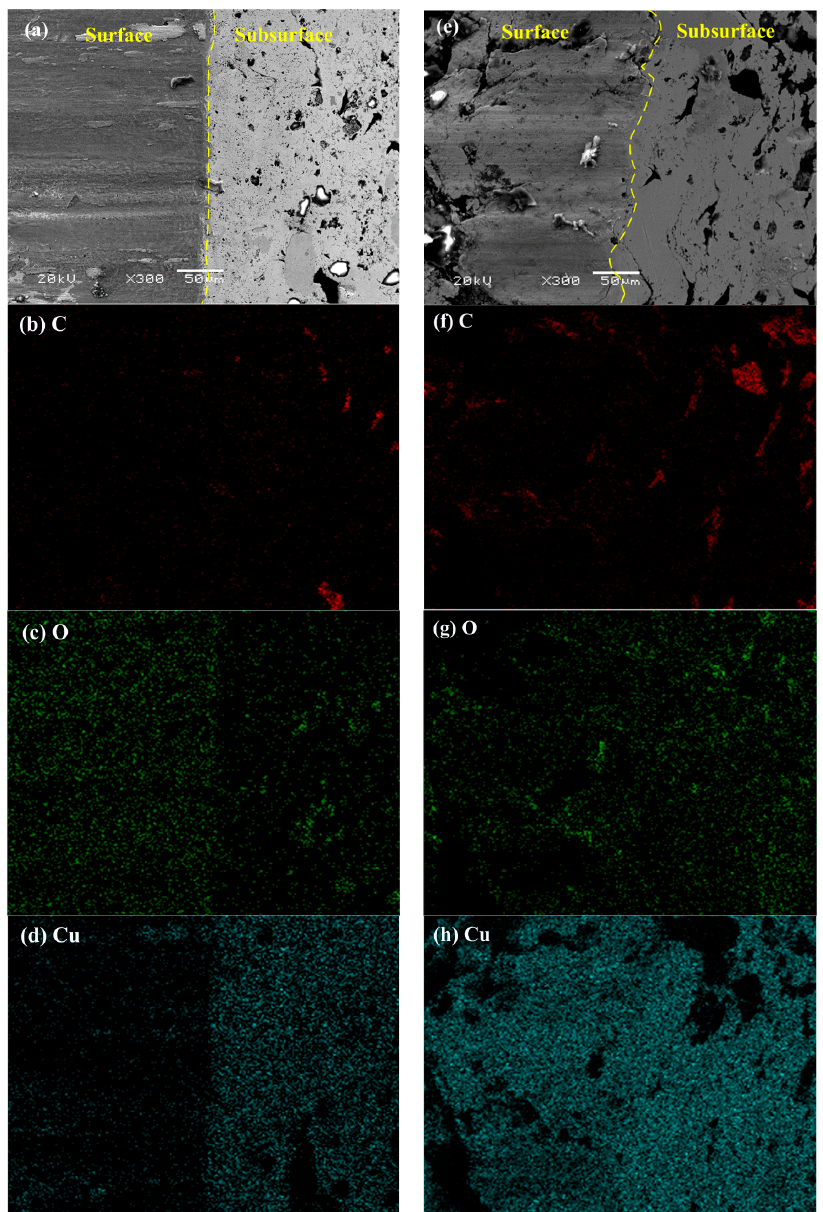
Figure 9. Morphologies and major elements distribution on the friction surface and subsurface of inclined-plane samples at 250 km/h and 0.4 Mpa for specimen S1 of ( a – d ) and specimen S2 of ( e – h ): ( a , e ) morphologies; ( b , f ) distribution of C; ( c , g ) distribution of O; ( d , h ) distribution of Cu. For specimen S1, it is seen that the difference between the surface and subsurface in the distribution of C is small (Figure 9b); however, the differences in the distribution of O and Cu are